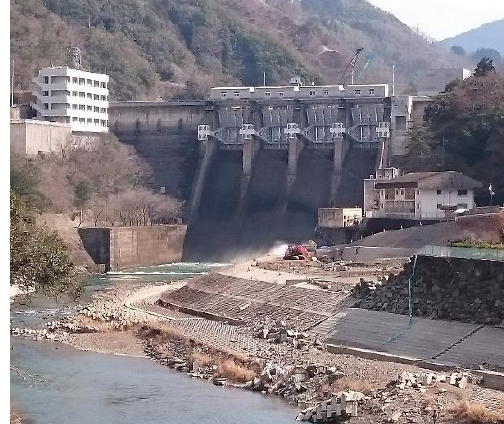
Figure 3. Kanogawa Dam and its management office (left).